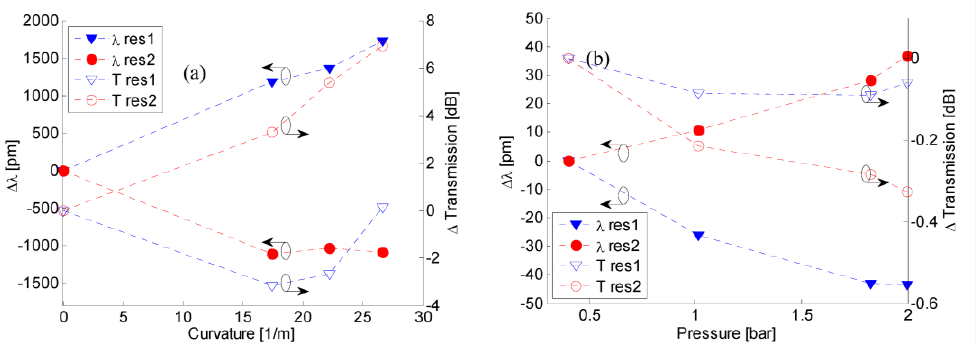
Figure 4. ( a ) Resonant wavelength shifts and peak transmission changes versus curvature; ( b ) Resonant wavelength shifts and peak transmission changes versus